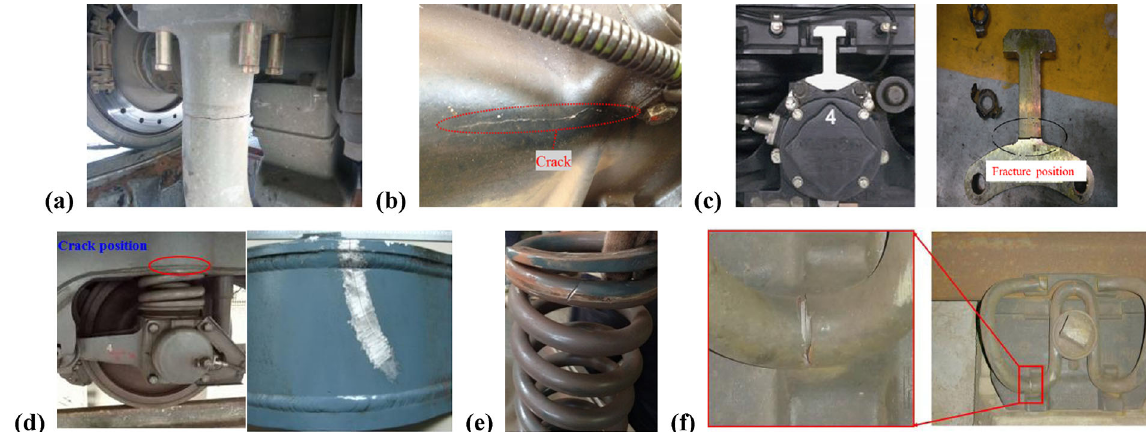
Fig. 14 Failure of vehicle and track components due to the excitation of wheel polygonisation in China: a supporting tube of the sanding device of locomotive [35]; b gearbox housing of high-speed EMU [57]; c vertical block of axle box of high-speed EMU [63]; d welded bogie frame of metro vehicle [64]; e steel coil spring of metro vehicle [16]; and f clip of rail fastener